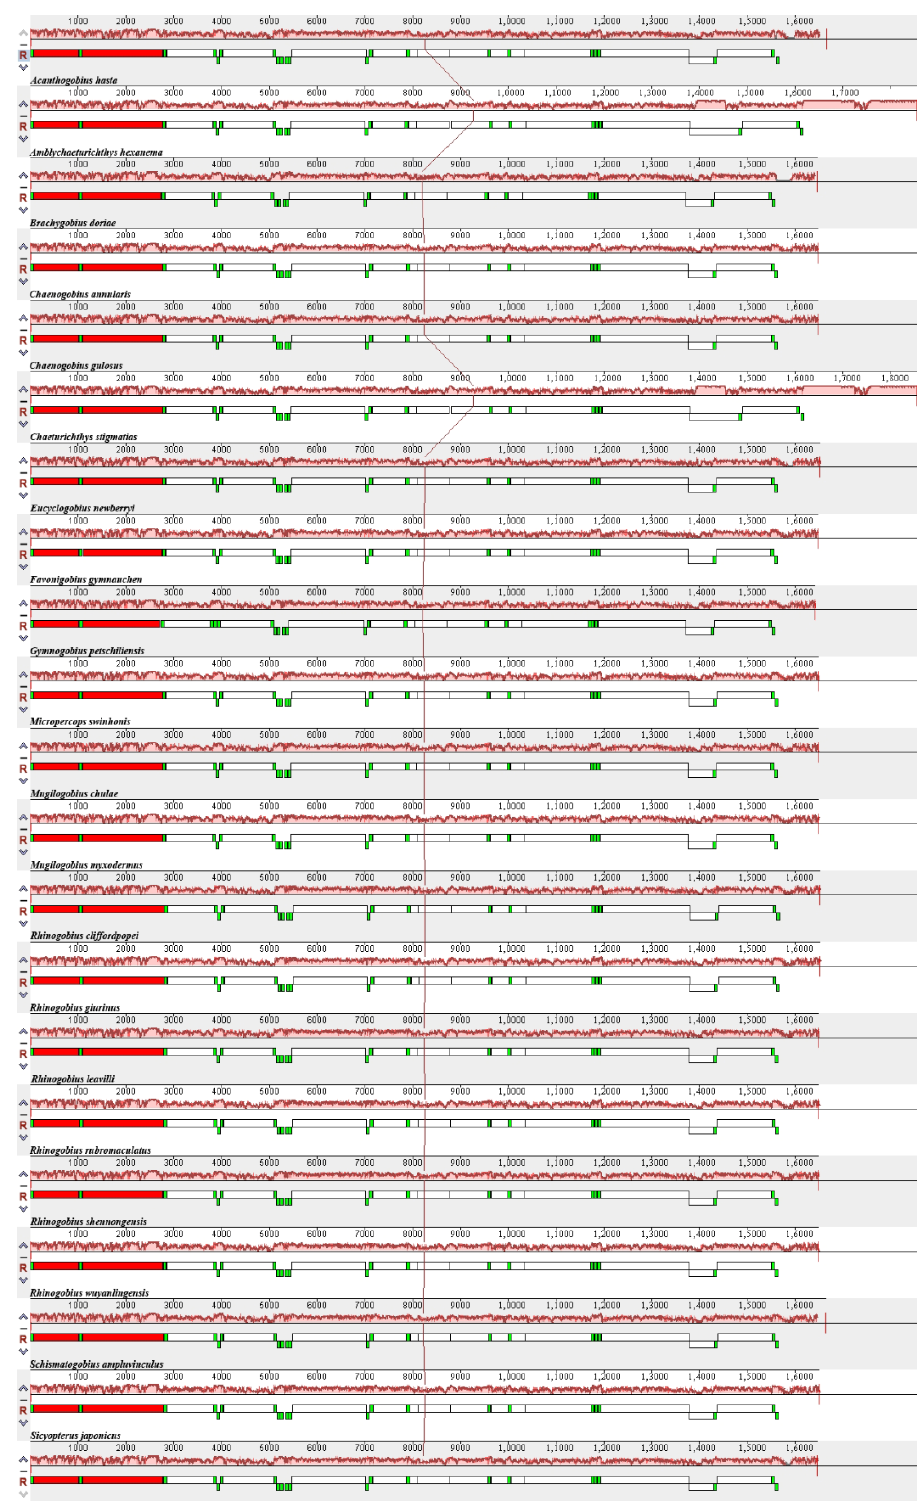
Figure 4. Alignment of the 21 species evaluated in this study using Mauve. Gene arrangement is shown in Tables 2–4. Red block is 12S rRNA and 16S rRNA, green block is tRNA, and white block is PCG.